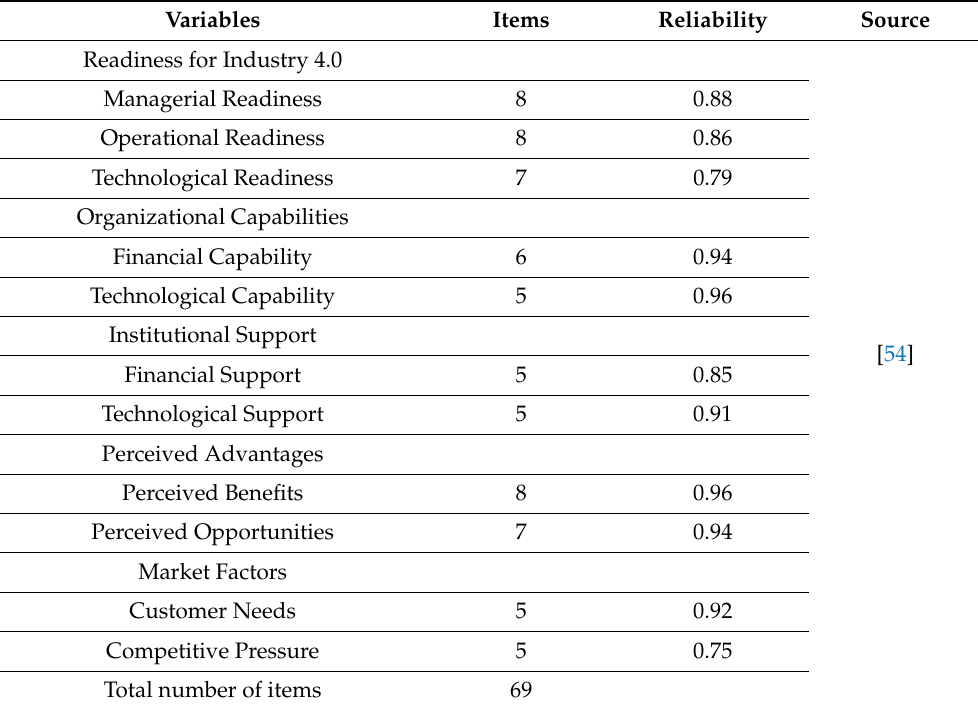
Table 1. Summary of measures used in the study.